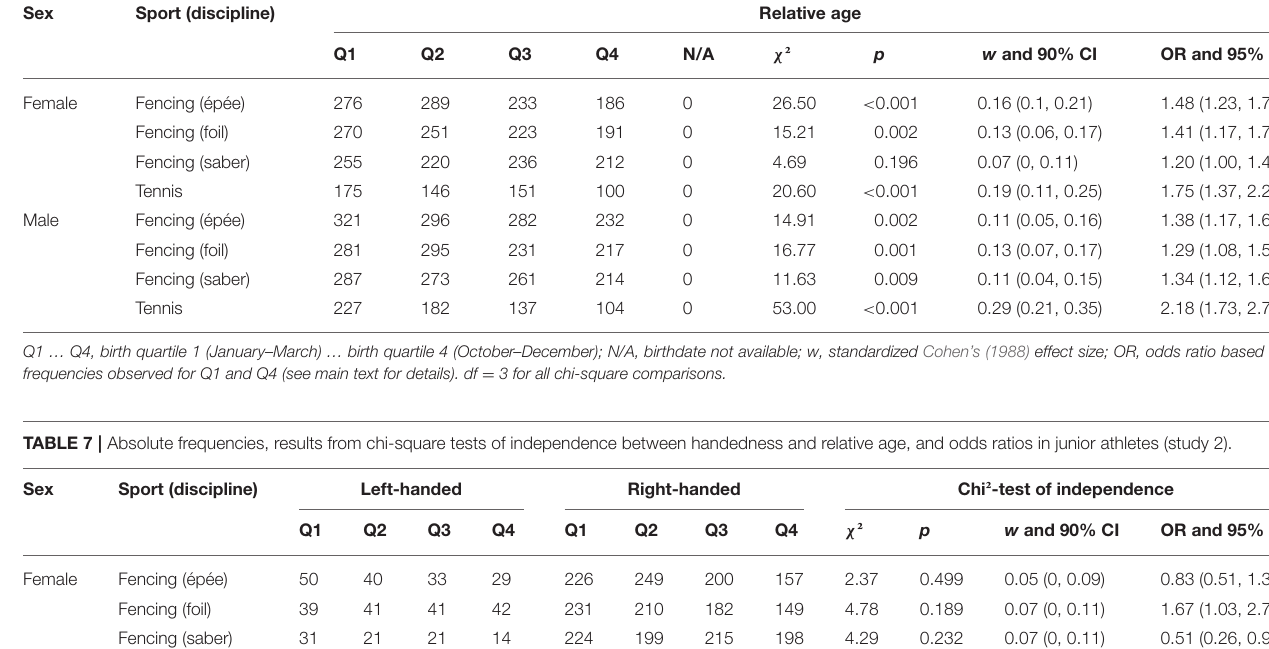
TABLE 6 | Absolute frequencies, results from chi-square goodness-of-fit tests, and odds ratios related to relative age in junior athletes (study 2). Sex Sport (discipline) Relative age